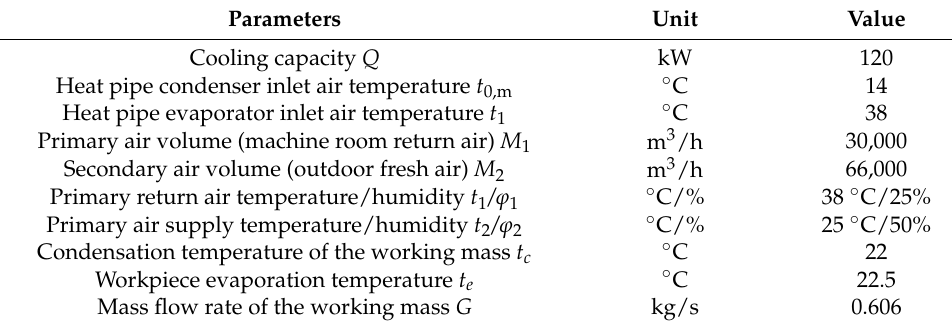
Table 2. Unit design